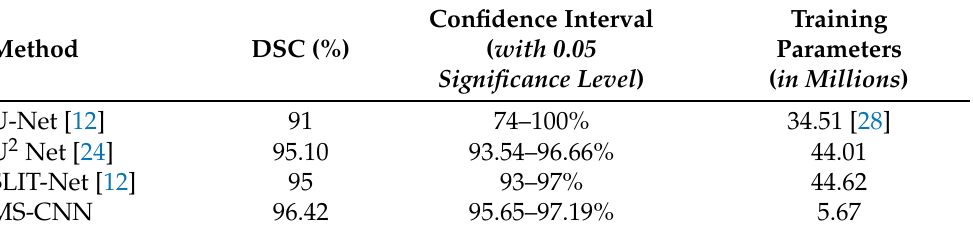
Table 1. Summary of average DSC of the proposed MS-CNN and state-of-the-art corneal limbus segmentation methods, using diffuse white light images (Loo et al.